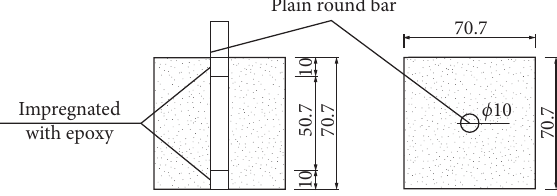
Figure 2: A schematic diagram of the electrochemical sample.